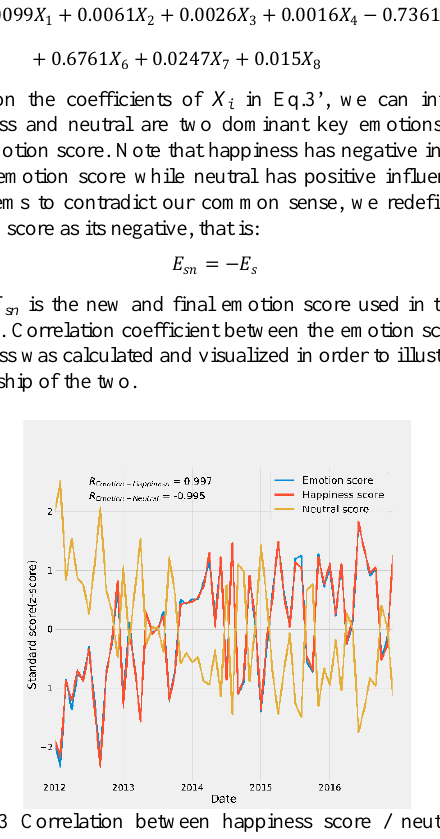
Figure 3 Correlation between happiness score / neutral and emotion score Figure 3 shows that the correlation coefficient between happiness and emotion score is 0.997, and -0.995 between neutral and emotion score. That means happiness and neutral are almost opposite in this